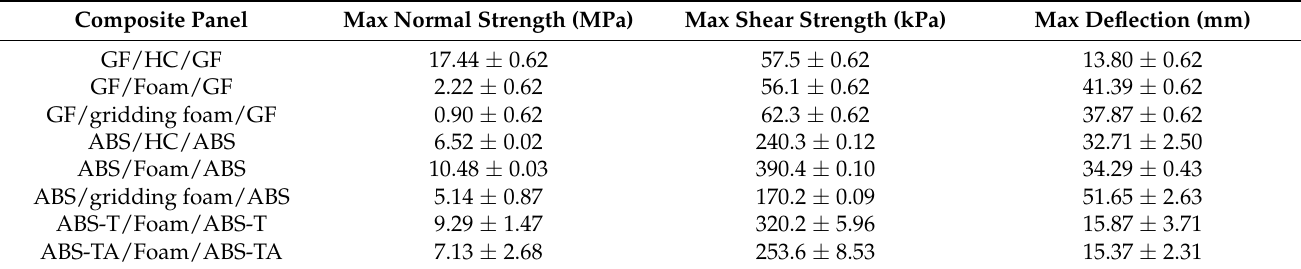
Figure 8. Representative load vs. displacement ( left ) and stress vs. strain ( right ) curves registered during the bending tests of GF/HC/GF, GF/Foam/GF, and GF/Gridding foam/GF panels. Table 2. Bending parameters.